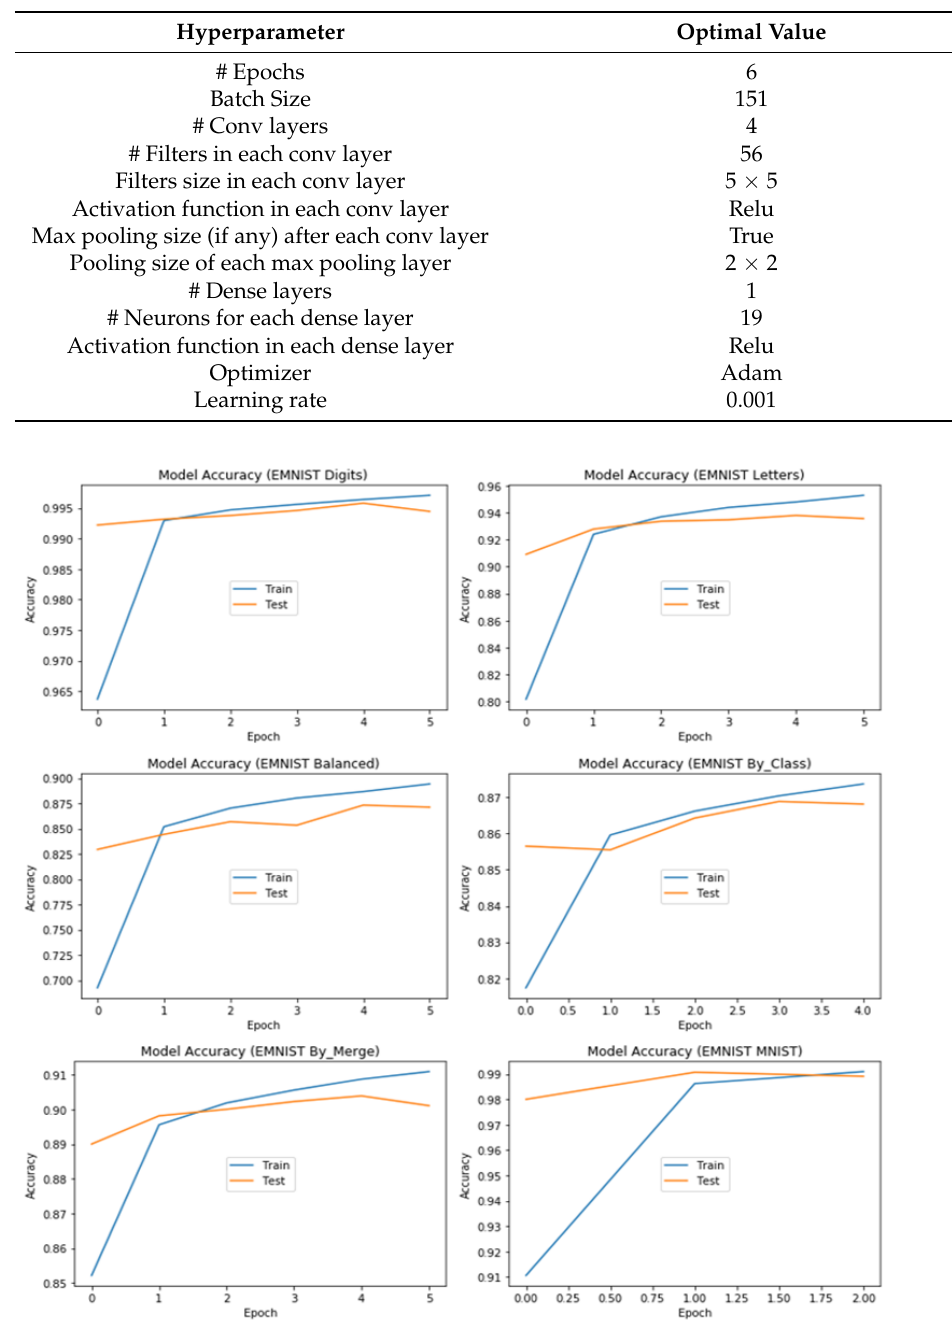
Figure 6. Training and test accuracy of the tuned architecture for each